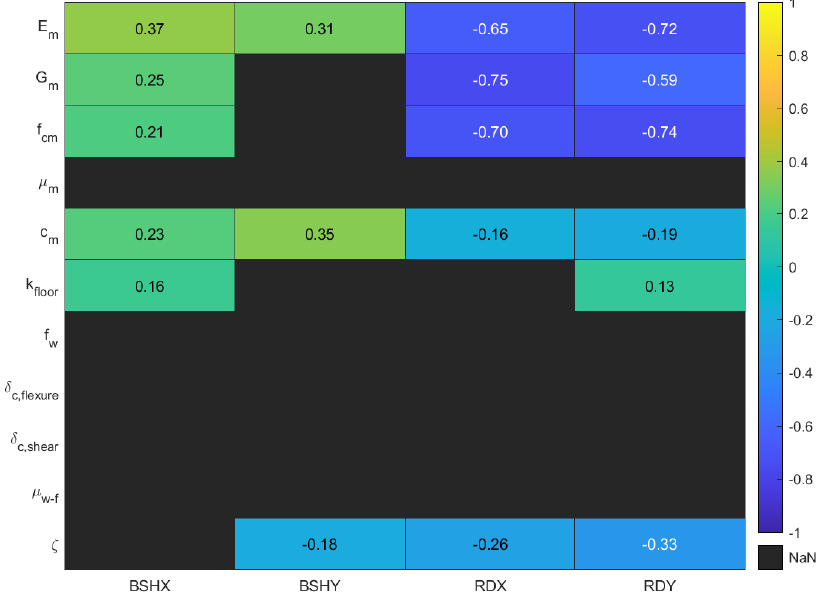
Figure 9. Holsteiner Hof model Spearman correlation matrix for PGA 0.21